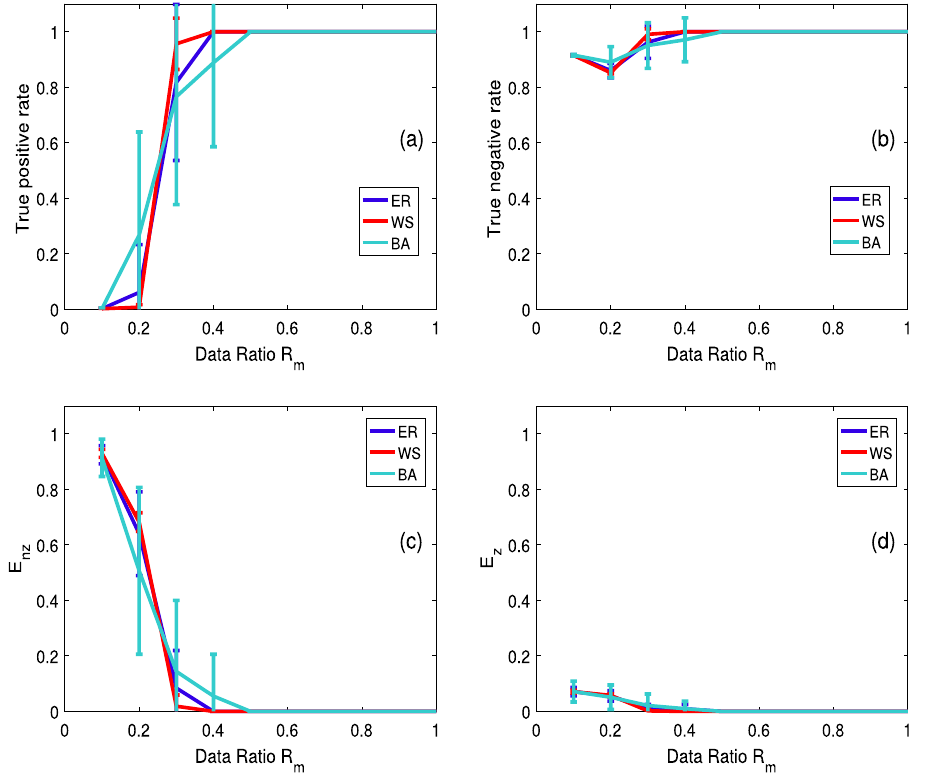
Figure 2. Identification results of disease propagation paths in three different networks: ER, WS, and BA. ( a ) True positive rate ( b ) True negative rate. ( c ) Average relative error ( d ) Average absolute